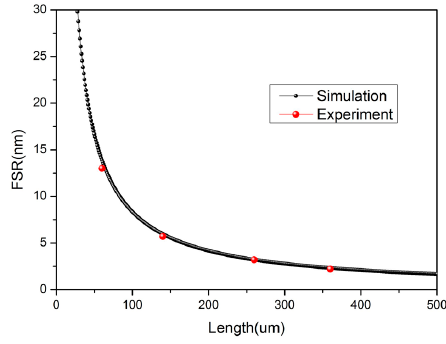
Figure 4. The relationship between FSR and L at the wavelength of 1550 nm.